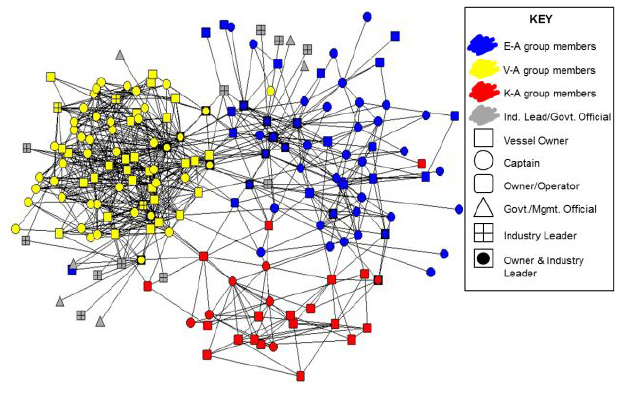
education, experience, age, and title) for all respondents. Densities marked with an * indicate significance at the 5% level according to the ANOVA test of variable homophily